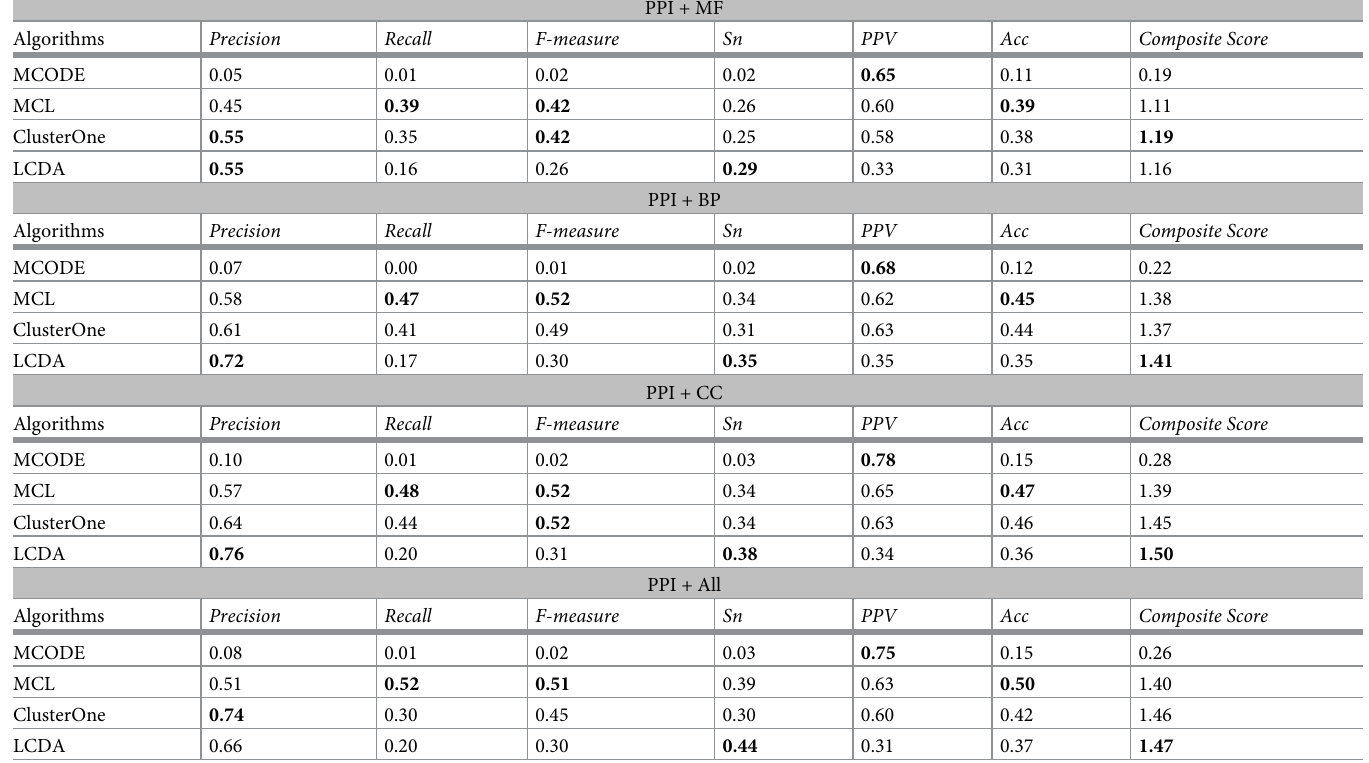
Table 4. Performance comparison of the communities of the algorithms that are based on only topology on Saccharomyces Cerevisiae Krogan interaction datasets. θ is 0.1.